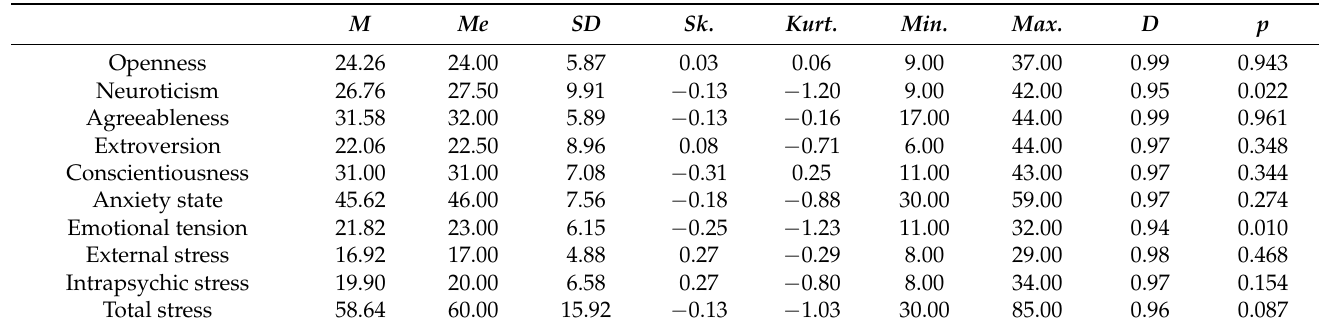
Table 1. Basic descriptive statistics of the quantitative